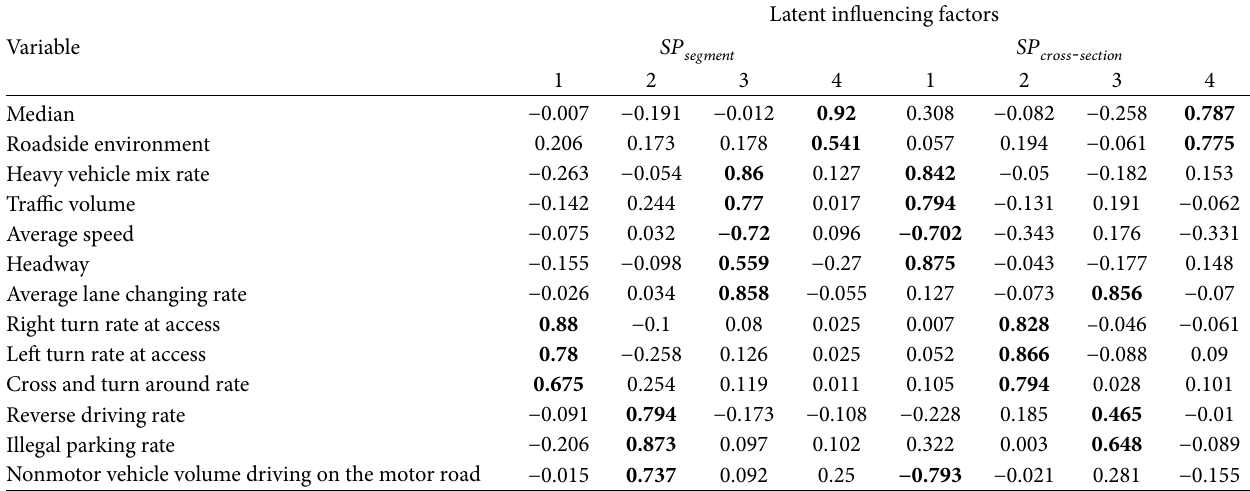
- and 𝑐𝑟𝑜𝑠𝑠 𝑠𝑒𝑐𝑡𝑖𝑜𝑛 𝑠𝑒 g 𝑚𝑒𝑛𝑡 𝑆𝑃 𝑆𝑃